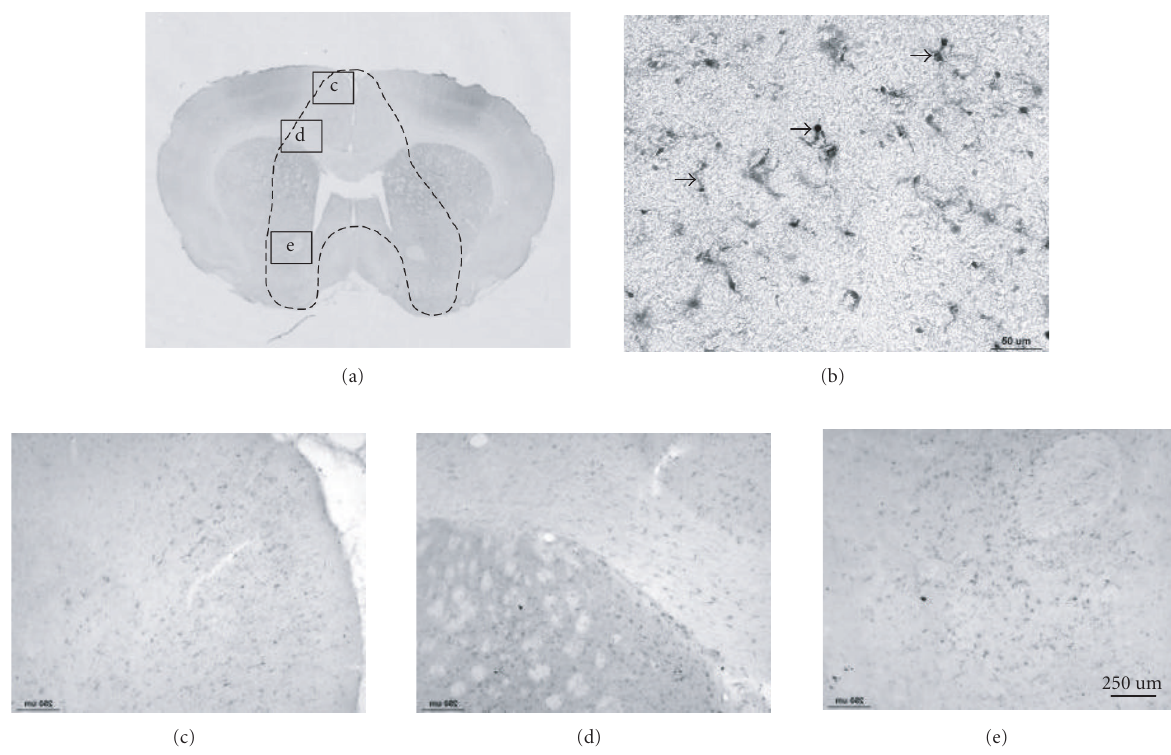
Figure 2: Distribution and cellular localization of IL-1 β immunoreactivity 7h after CHI. As indicated by the dashed line in (a), IL-1 β expression is not restricted to the site of primary cortical injury but extends to deeper brain areas including the corpus callosum, the basal ganglia, and the piriform cortex as well. Boxed areas are displayed at higher magnification in (c), (d), and (e). (b) is a high power view showing that IL-1 β -positive cells have the typical ramified morphology of resident